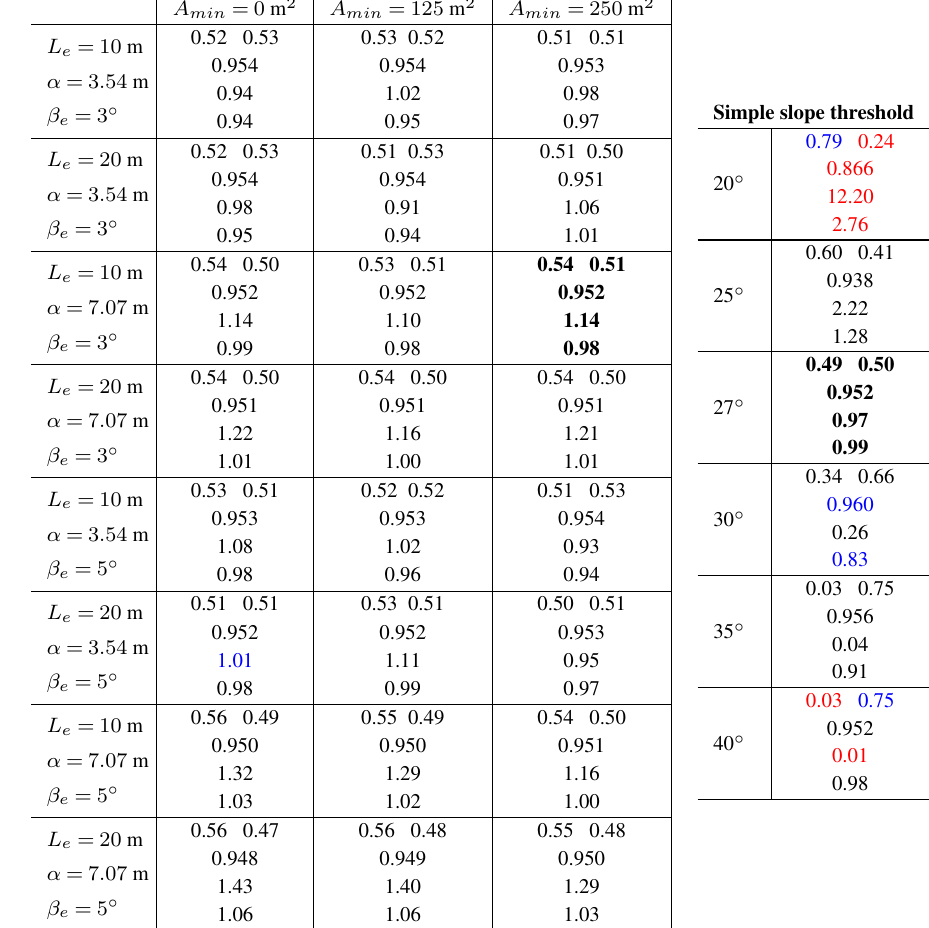
and 4 pixel length; and α at ( pixel length × × ∗ ×√ 2) / 2